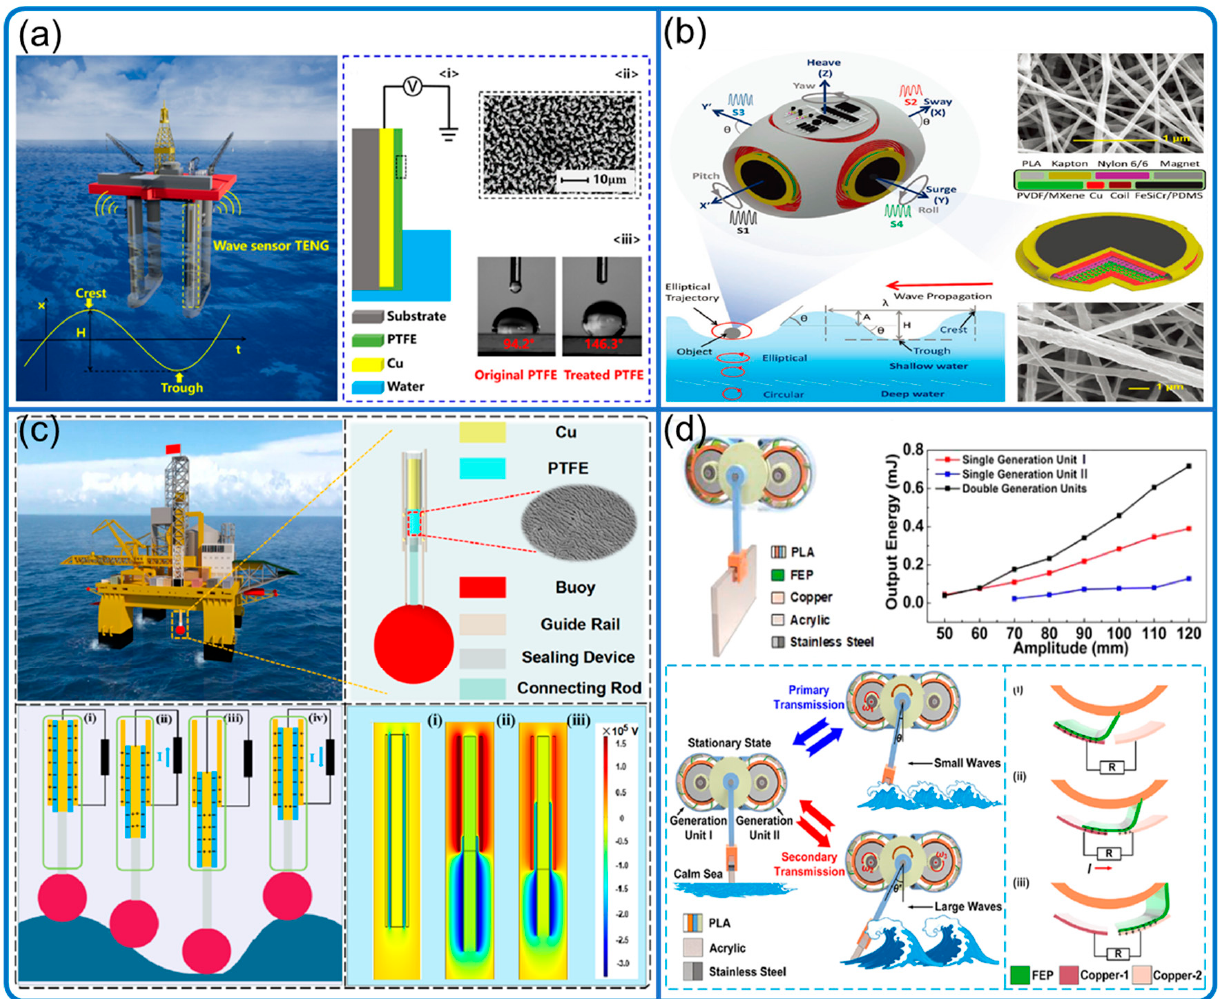
Figure 10. Sea wave motion sensing. ( a ) Highly sensitive wave sensor. Reproduced with permission. Copyright 2019, Elsevier [73]. ( b ) Self-powered arbitrary wave motion sensing system. Reproduced with permission. Copyright 2022, Wiley Online Library [78]. ( c ) Ocean surface water wave sensor. Reproduced with permission. Copyright 2020, American Chemical Society [75]. ( d ) Ocean wave sensor with graded energy harvesting. Reproduced with permission. Copyright 2021, American Chemical Society [76].